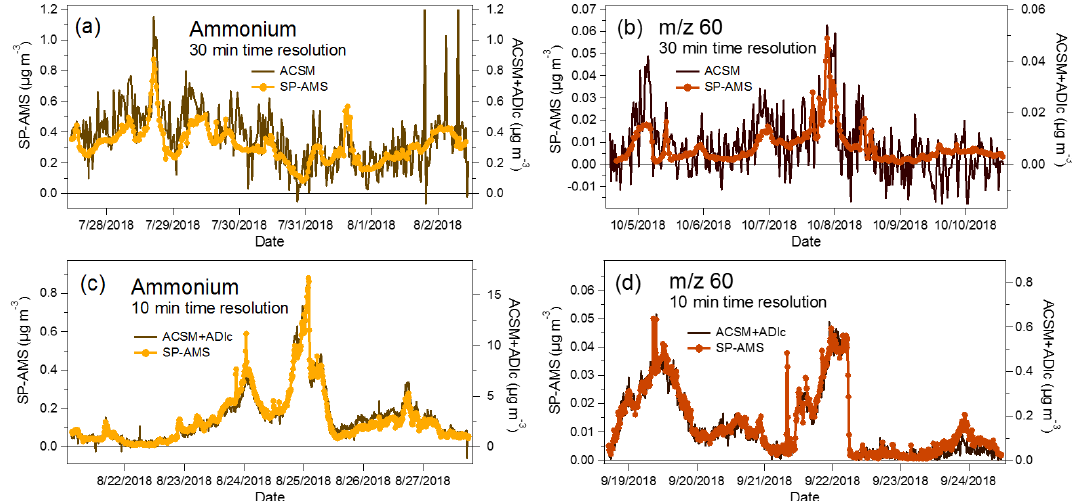
Figure 9. Time series of ammonium and m/z 60 with 30min time resolution with ACSM and SP-AMS ( a – b ) and 10min time resolution with SP-AMS and ACSM + ADIc (c) – (d) at SMEAR